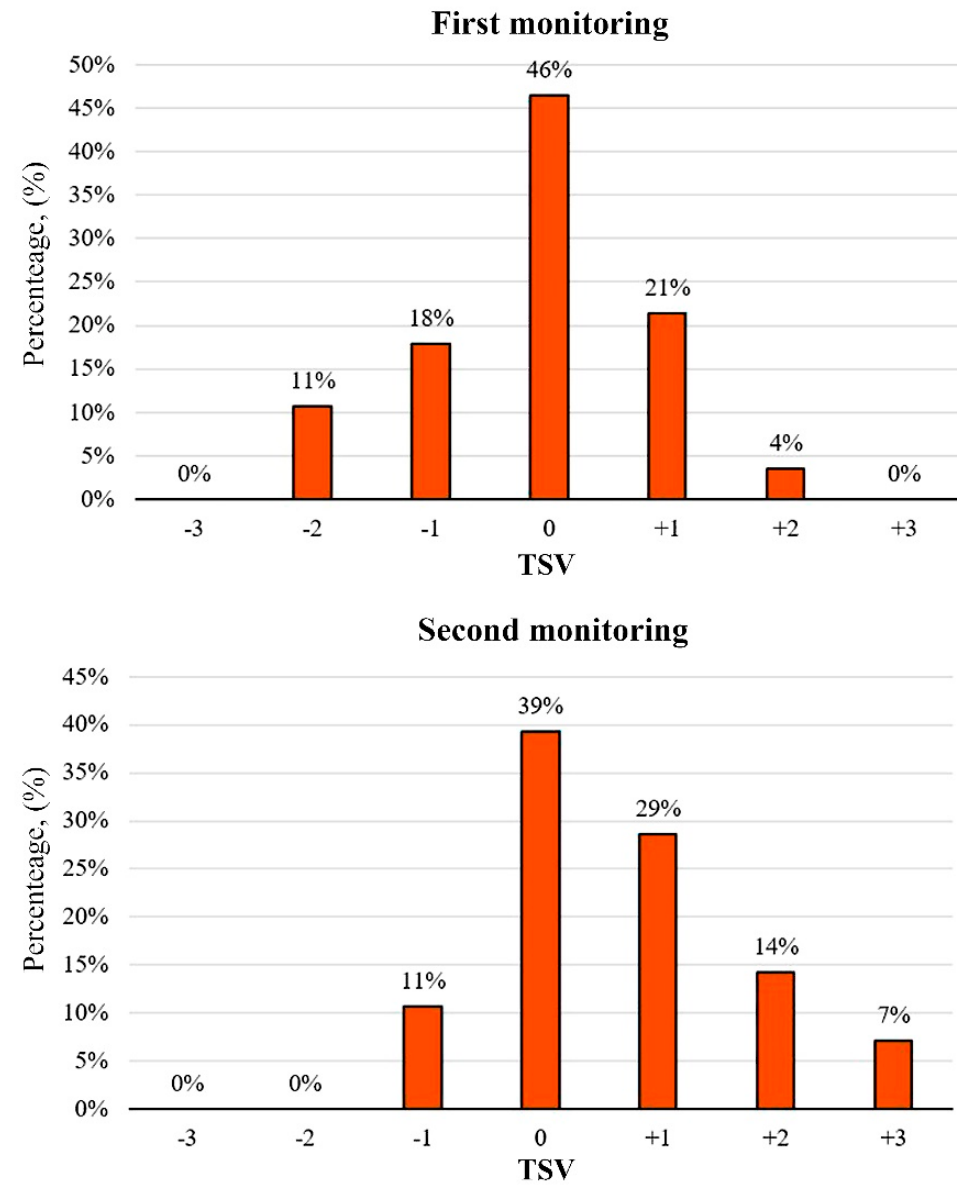
Figure 7. The distribution of users’ individual thermic sensation perceptions during the first and second monitoring periods. Data from: Environmental monitoring.